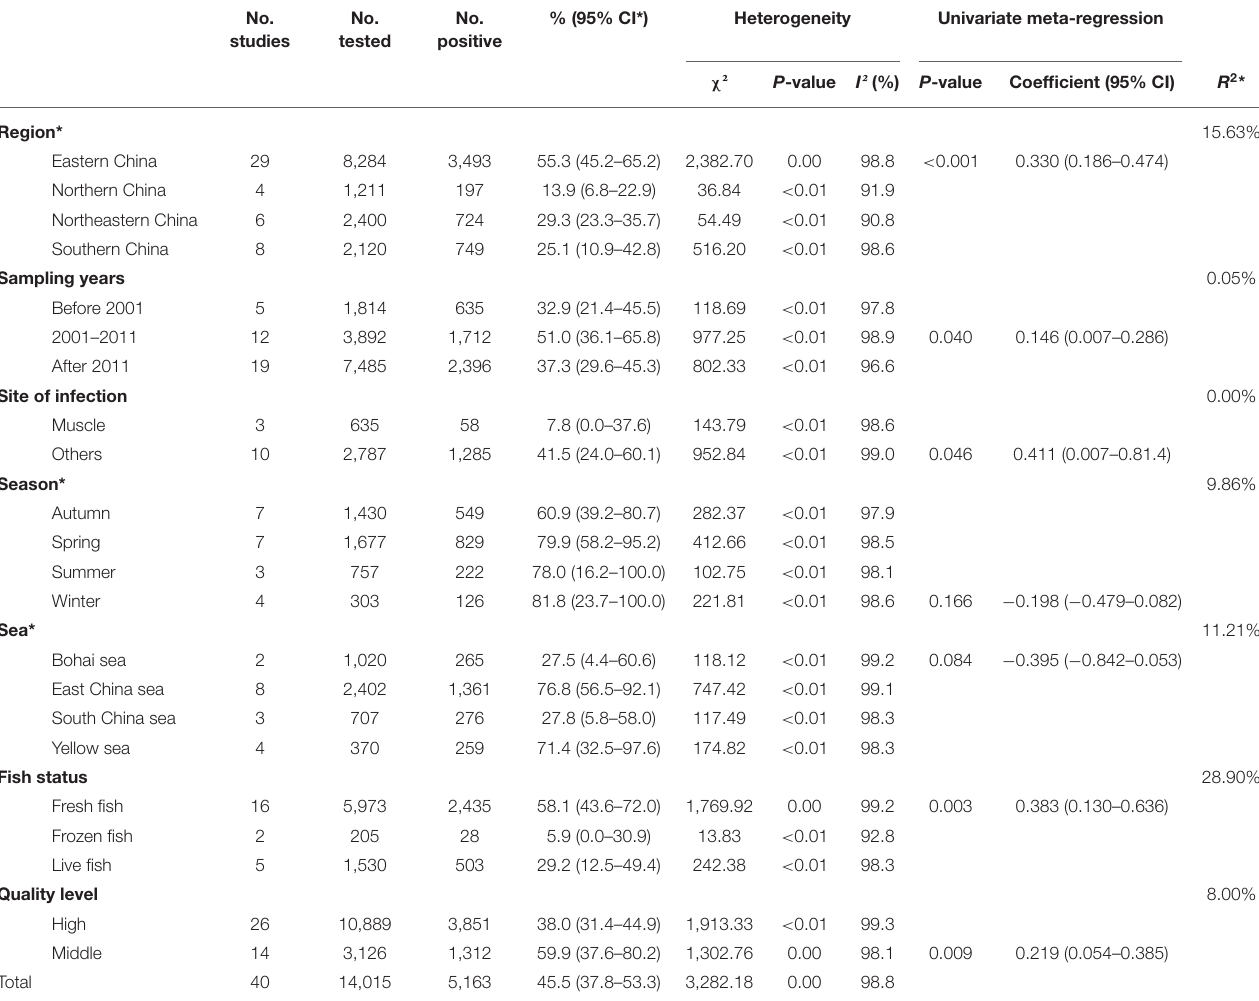
TABLE 4 | Pooled prevalence of anisakid nematodes in China.